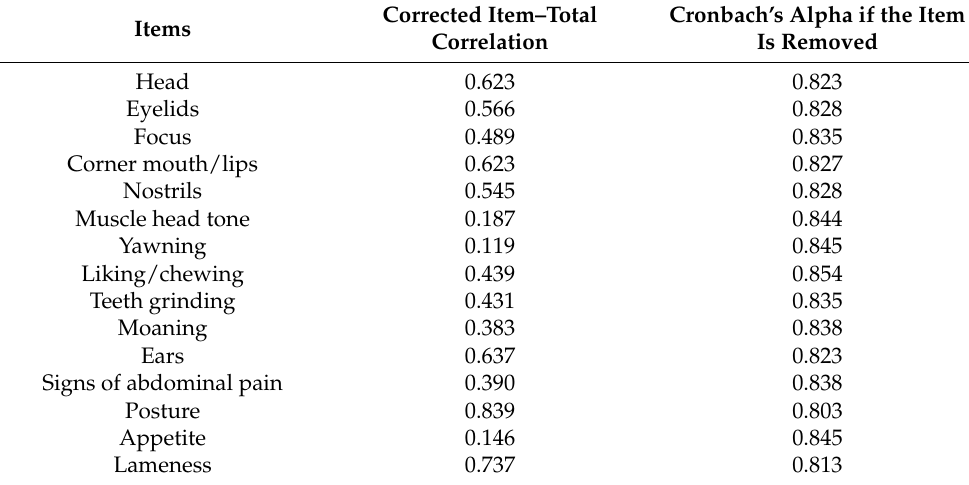
Table 8. Internal consistency and item–total correlation of the Sections I and II of the FCPS using the scores given by the clinician (CJ) and the 5 observers. The Cronbach’s alpha was also repeatedly assessed by removing each item individually to consider its effect on the consistency of the scale itself. Corrected Item–Total Cronbach’s Alpha if the Item Items Correlation Is